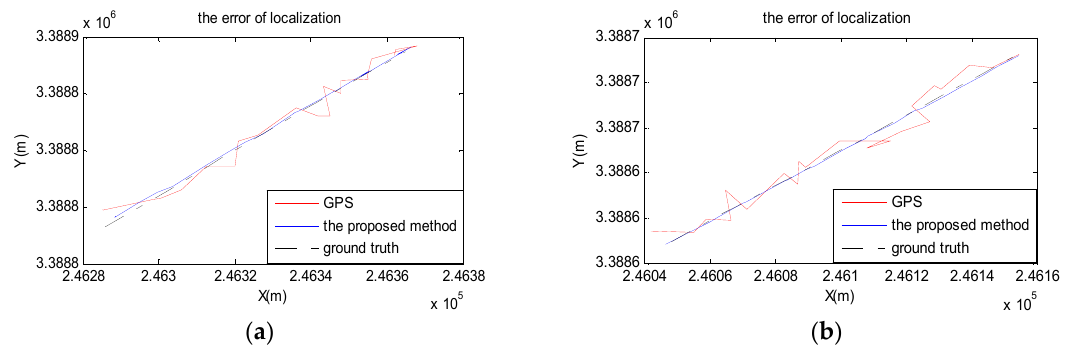
Figure 11. The results of localization. ( a ) urban road; ( b ) school road.